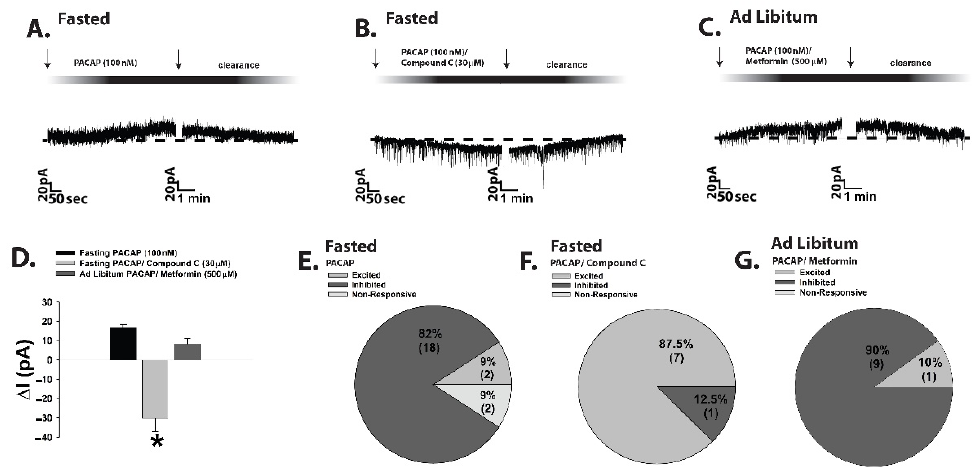
Figure 7. The fasting-induced reversal of the PACAP response in POMC neurons is also dependent upon activation of AMPK. The outward current caused by PACAP under fasting conditions in POMC neurons ( A ; n = 12) is transformed into an inward current in the presence of the AMPK inhibitor Compound C (30 µ M; B ; n = 8) The PACAP-induced outward current in ( A ) was reproduced under ad libitum-fed conditions in the presence of the AMPK activator metformin (500 µ M; C ; n = 10). The data from these representative traces is summarized in composite form by the bar graph in ( D ) and the pie charts in ( E – G ). Bars represent means and lines 1 SEM. *, p < 0.05 relative to PACAP alone, one-way ANOVA/LSD.